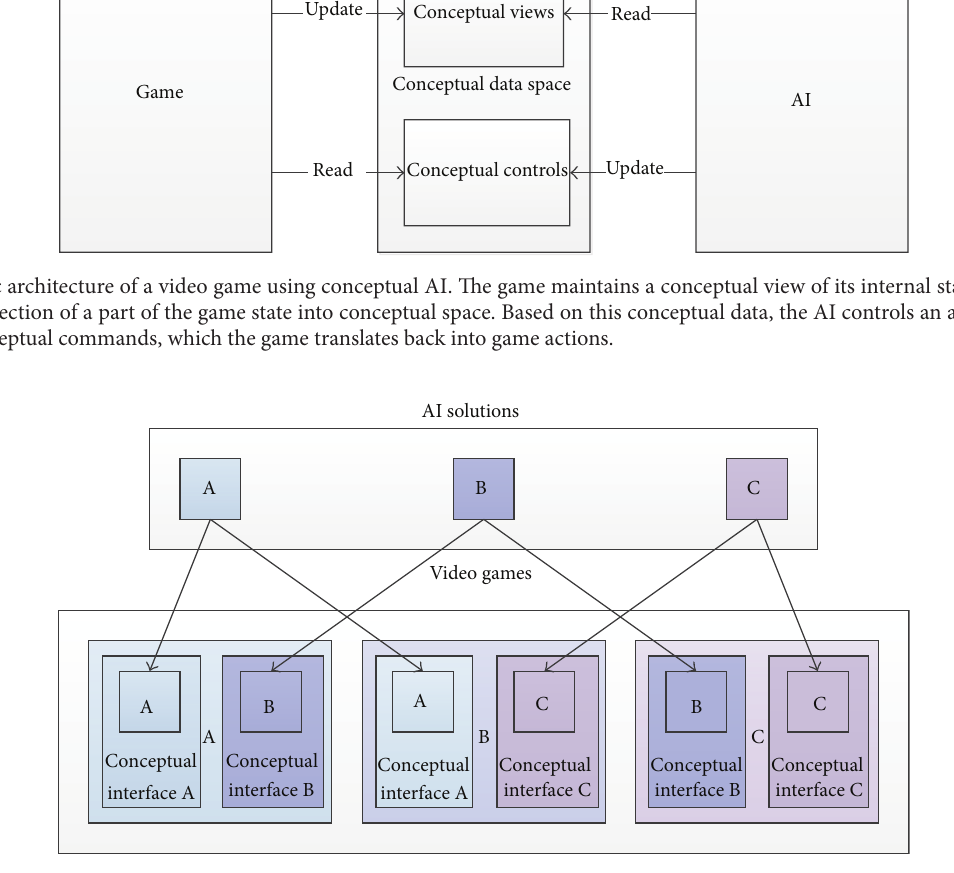
Figure 3: Using the same AI in multiple games. AI A can run in games A and B because both implement the conceptual interface A it requires. A conceptual interface is a set of conceptual views and